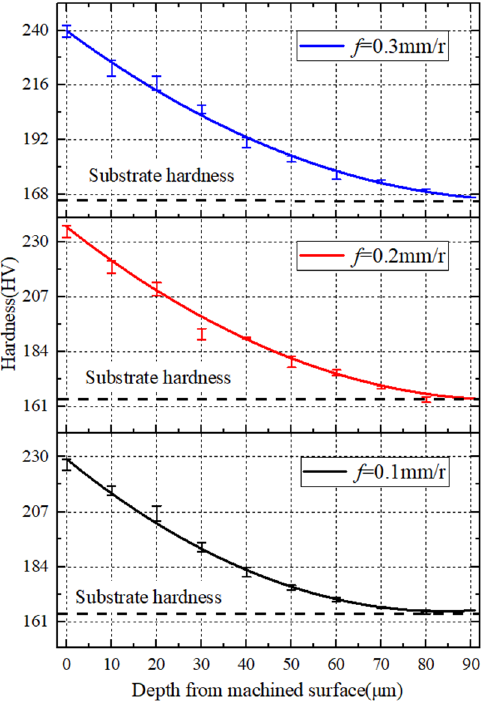
Figure 18. ( v = 260 m/min) Influence of feed rate on work hardening. Comparing the simulation data with the test data at f = 0.1 mm/r, v = 260 m/min, it is found that when the depth from the machined surface is between 0 and 40 µ m, the hardness of the metamorphic layer changes greatly, as shown in the area on the left side of the dashed line in Figure 19. The transformation amplitude tends to be gentle at 40~90 µ m, as shown in the area on the right side of the dashed line of Figure 19, which is the same as the change trend of the above simulation strain and temperature, thus verifying the accuracy of the finite element simulation.